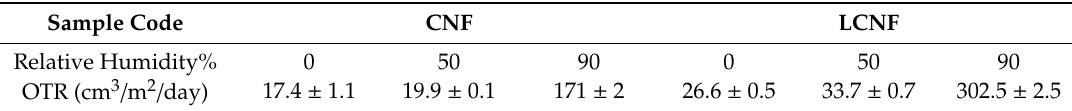
Oxygen transmission rates for CNF and LCNF coated films under 0, 50 and 90% relative